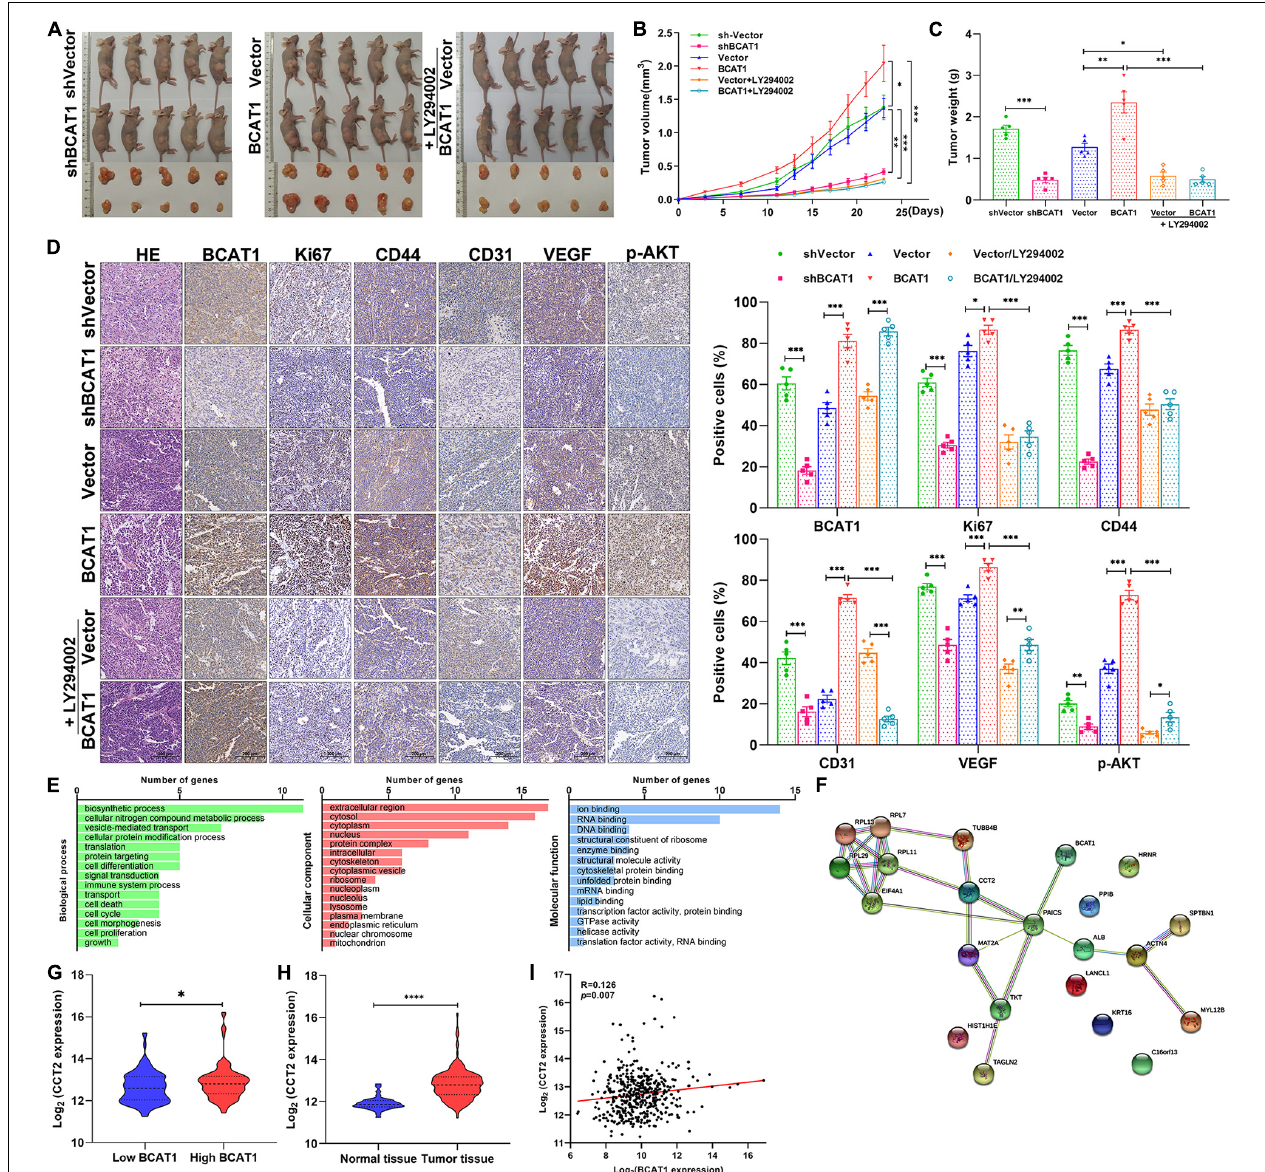
FIGURE 5 | BCAT1 enhances angiogenesis and tumorigenicity by activating PI3K/AKT/mTOR signaling in GC xenograft models. (A) Tumor xenografts were generated using BCAT1-silencing or BCAT1-overexpressing BGC-823 cells. Mice with BCAT1 overexpression were treated with or without LY294002. Images of tumors are shown ( n = 5). (B) Tumor growth curve and (C) tumor weight in each group. (D) Representative images of H&E staining and IHC staining for BCAT1, Ki67, CD44, CD31, and p-AKT ( n = 5). (E–I) Analysis of BCAT1-interacting proteins in the exploratory research. (E) Representative enrichment pathways of 21 genes revealed by gene ontology (GO) analysis. (F) Network of 21 genes using String-DB analysis. (G) CCT2 was differentially expressed between BCAT1-high and -low group (top quartile vs. bottom quartile in TCGA database). (H) CCT2 expression in The Cancer Genome Atlas (TCGA) gastric cancer dataset. (I) Correlation between BACT1 and CCT2 expression in TCGA gastric cancer dataset. **** p <